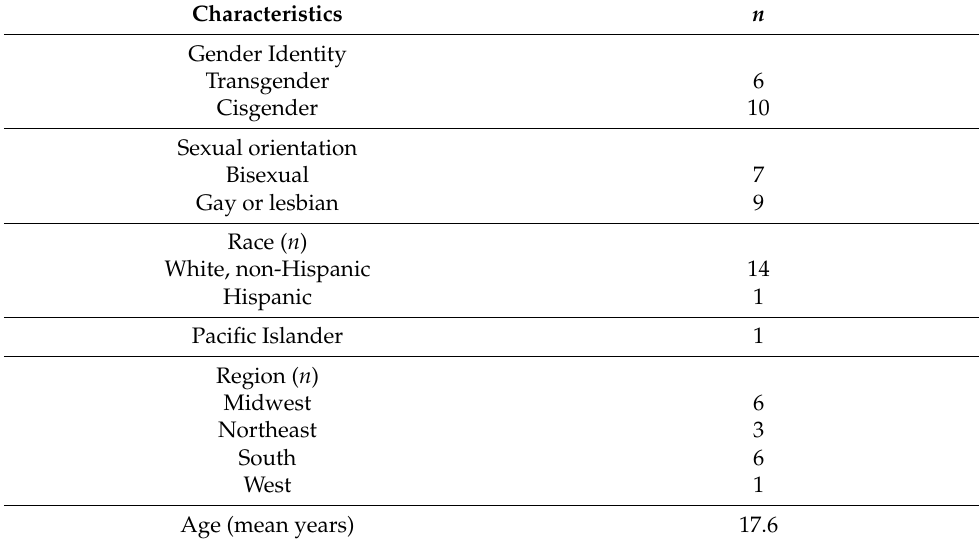
Table 1. Self-Identified Demographics ( n = 16).